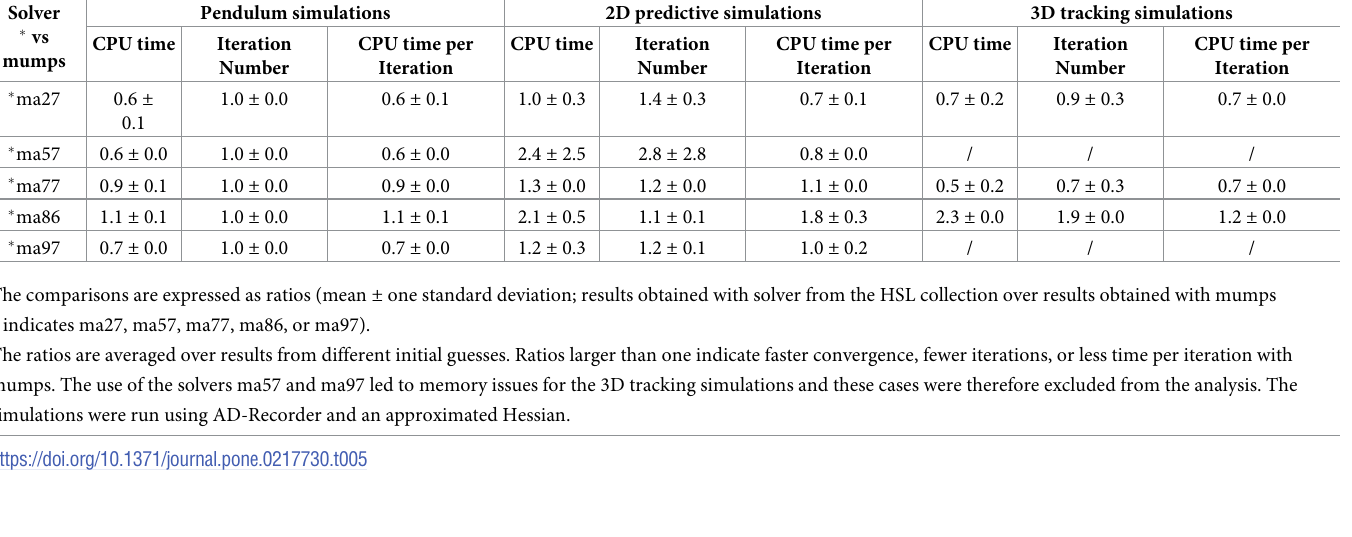
Table 5. Comparison of computational time, number of iterations, and computational time per iteration between linear solvers. Solver �